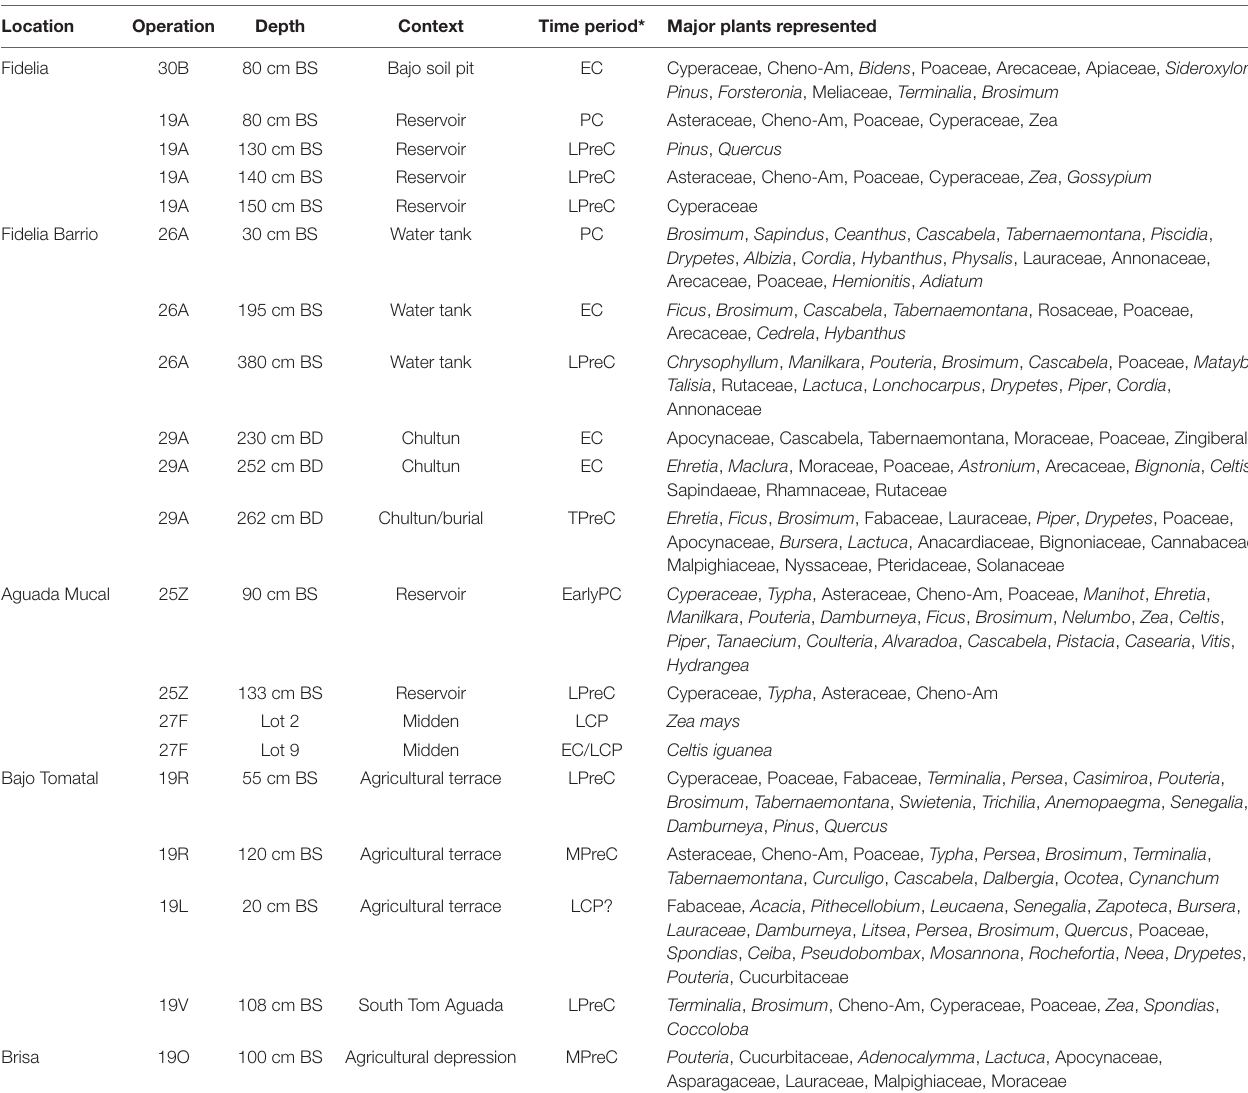
TABLE 3 | Yaxnohcah ancient plant remains listed by